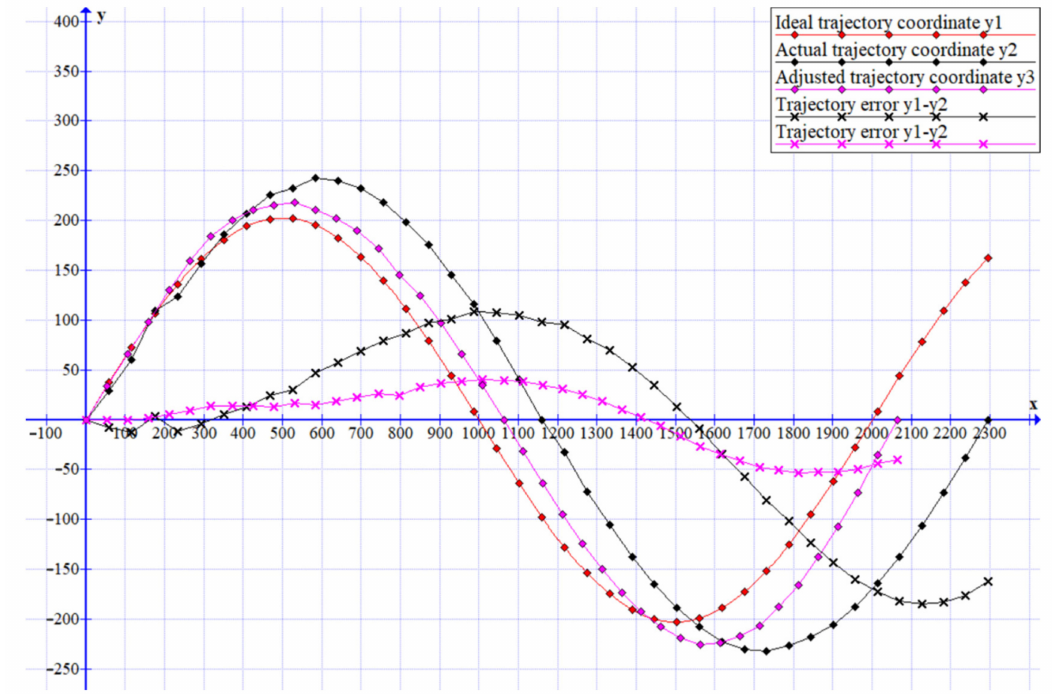
Figure 13. Raw and adjusted trajectories.